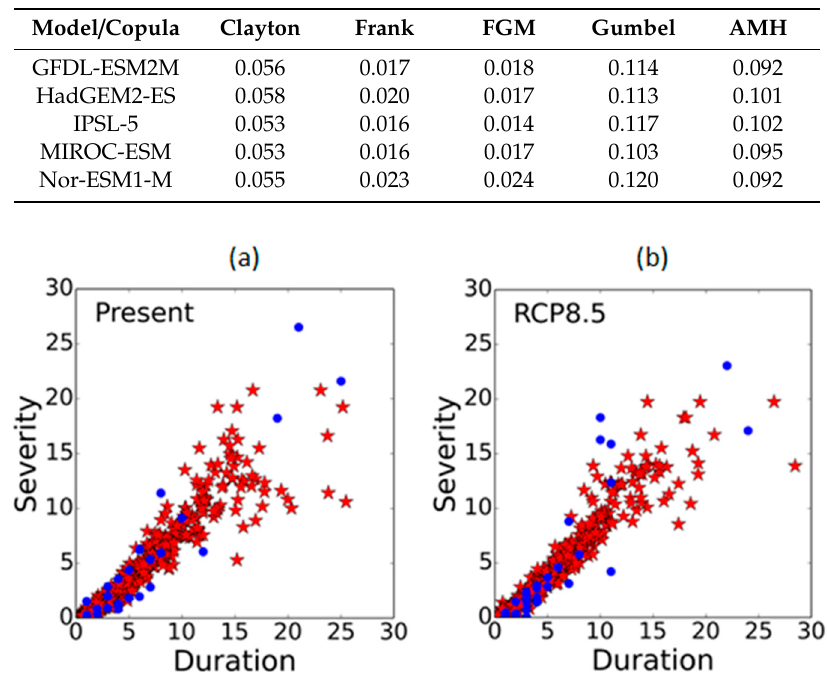
Table 1. RMSE from di ff erent copula fit and di ff erent GCM models, period 1971–2000.